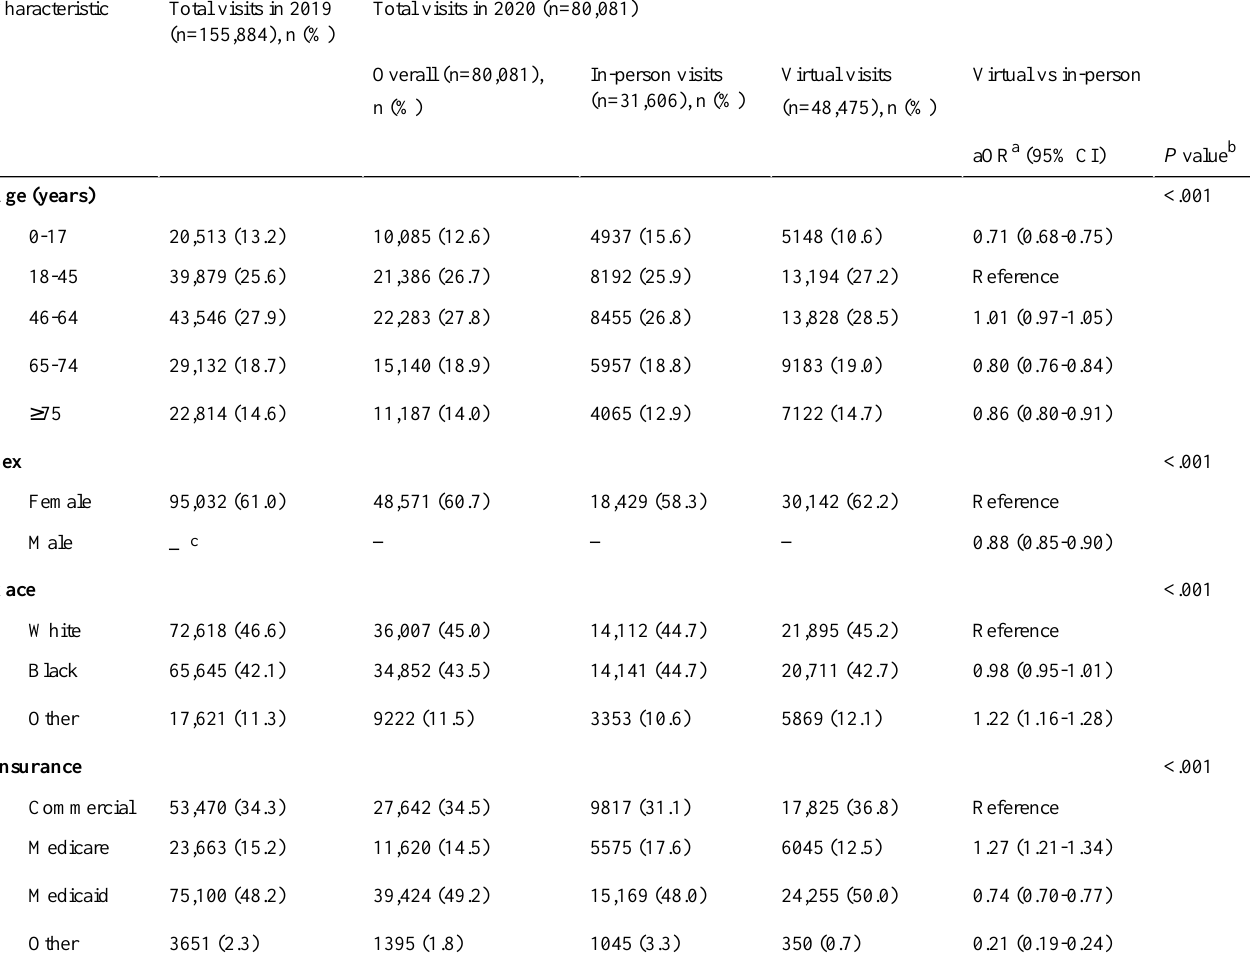
Table 1. Associations between patient sociodemographics and ambulatory visit type from March 15 to May 31 in 2019 and